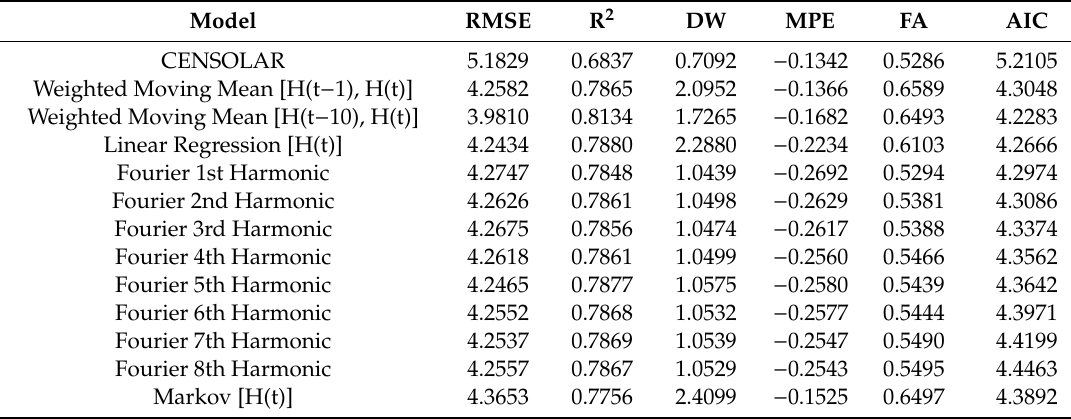
Table 2. Fitting achieved with the evaluated simulation classical models of solar radiation, between the simulated values of the horizontal daily global solar irradiation the day after and the values measured in 2011 at the agrometeorological station in Mansilla Mayor (Le ó n, Spain).